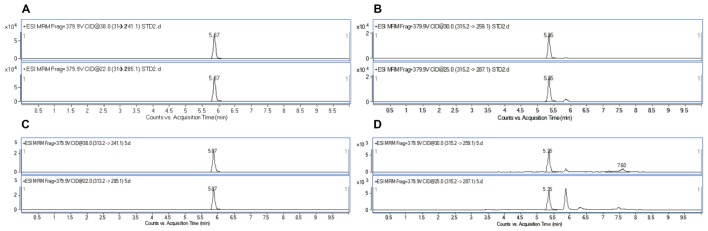
HPLC/MRM-chromatograms for synchronous confirmation of AFB1 and AFB2 in locust sample. (A) AFB1 standard solution; (B) AFB2 standard solution; (C) No. 1 sample contaminated with AFB1; (D) No. 8 sample contaminated with AFB2.